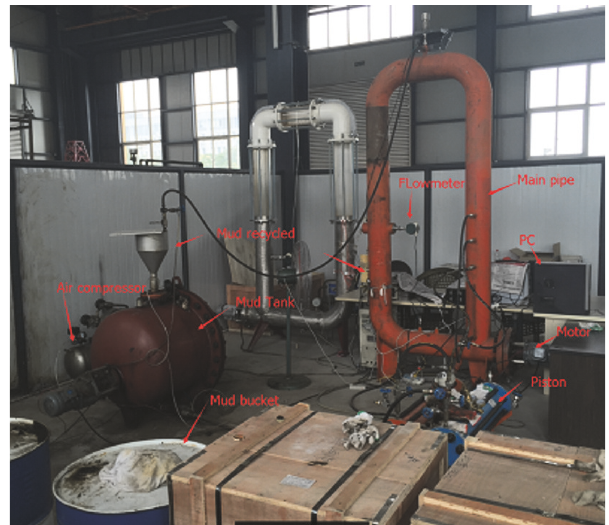
Figure 11: Experimental platform of the deep-water drilling gas